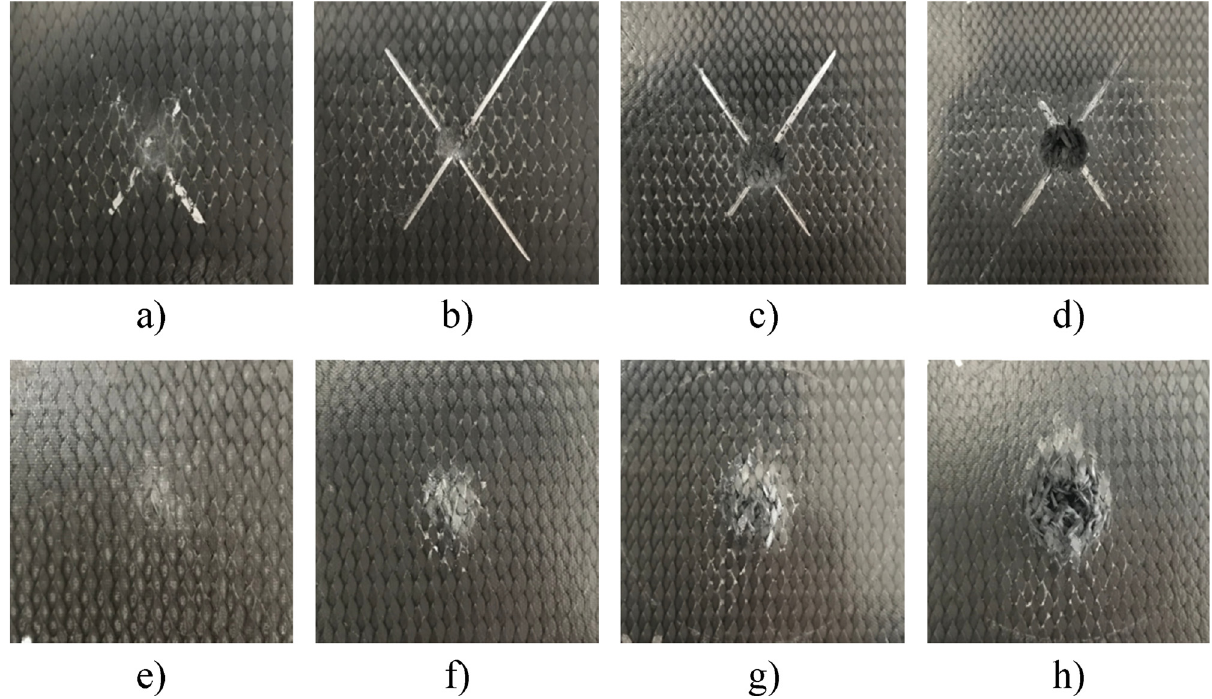
Figure 6: Surface damage of 30° braided angle specimens after impact of spherical punch: ( a ) top surface after 1 impact, ( b ) top surface after 5 impacts, ( c ) top surface after 20 impacts, ( d ) top surface after 44 impacts, ( e ) backside after 1 impact, ( f ) backside after 5 impacts, ( g ) backside after 20 impacts, and ( h ) backside after 44